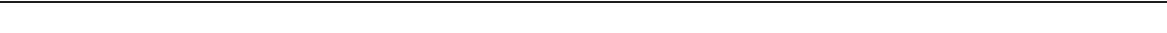
Fig. 1 Histologic and immunohistochemical features of adenomyoepitheliomas. a − f Representative micrographs of hematoxylin-and-eosin (H&E)-stained adenomyoepitheliomas included in this study. a Low-power magni fi cation of AM2, a multilobulated lesion, of tubular architectural pattern, with well- circumscribed borders (scale bar, 1 mm). b Intermediate-power magni fi cation of AM39 displaying the typical bi-layered glandular architecture of adenomyoepitheliomas, comprising abluminal myoepithelial cells with clear cytoplasm and inner cuboidal epithelial cells with eosinophilic cytoplasm and apical snouts (scale bar, 200 μ m). c AM9 displaying areas of comedo-like necrosis (*, scale bar, 200 μ m). d AM8 displaying nuclear atypia and mitotic fi gures (arrowheads, scale bar, 100 μ m). e AM5 displaying an adenomyoepithelioma component (lower left corner, *) in association with a larger high- grade myoepithelial carcinoma (**), with large central necrosis in the upper right corner (***, scale bar, 1 mm). f Axillary lymph node metastasis of AM5 (scale bar, 1 mm), where the biphasic architecture is maintained. *, residual lymph node; **, metastatic lesion. g Representative micrographs of estrogen receptor (ER)-negative and ER-positive adenomyoepitheliomas. On the left, H&E stain of each case (scale bars, 100 μ m). On the right, ER immunohistochemistry results. Note the internal positive control (*) in the ER-negative case. h Stacked bar plots showing the frequency of histologic features indicative of a more aggressive behavior (nuclear grade, mitotic rate, and necrosis) and of the presence of associated carcinoma according to ER status (ER-positive versus ER-negative comparisons were performed using two-tailed Fisher ’ s exact tests). The histologic features are color-coded according to the legends. AME, adenomyoepithelioma. i Stacked bar plots showing the frequency of the expression of androgen receptor, HER2, Ki67, and p53 according to ER status (ER-positive versus ER-negative comparisons were performed using two-tailed Fisher ’ s exact tests). AME, adenomyoepithelioma; AR, androgen receptor; Equiv, equivocal; Neg, negative; Pos,